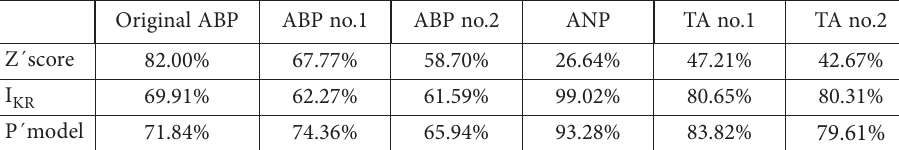
Table 7. Total accuracy with and without apparent signs (source: authors) Original ABP ABP no.1 ABP no.2 ANP TA no.1 TA no.2